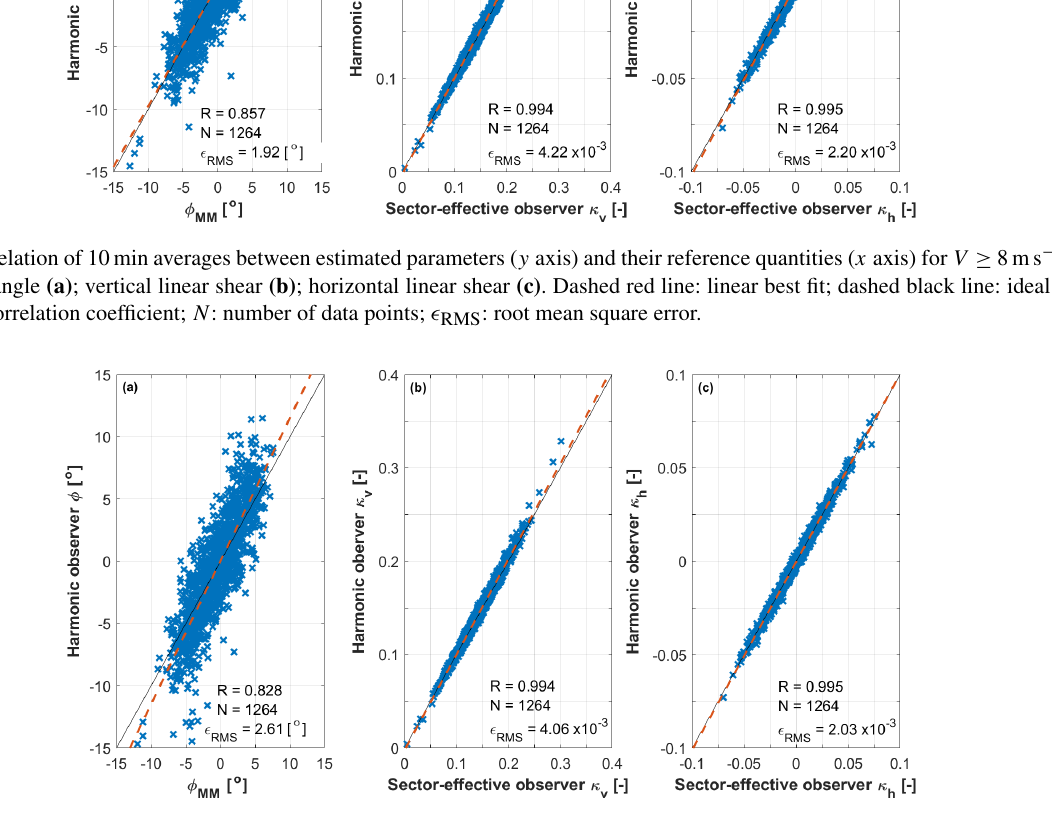
Figure 8. Correlation of 1min averages between estimated parameters ( y axis) and their reference quantities ( x axis) for V ≥ 8ms − 1 . Yaw misalignment angle (a) ; vertical linear shear (b) ; horizontal linear shear (c) . Dashed red line: linear best fit; dashed black line: ideal match; R : Pearson’s correlation coefficient; N : number of data points; (cid:15) RMS : root mean square